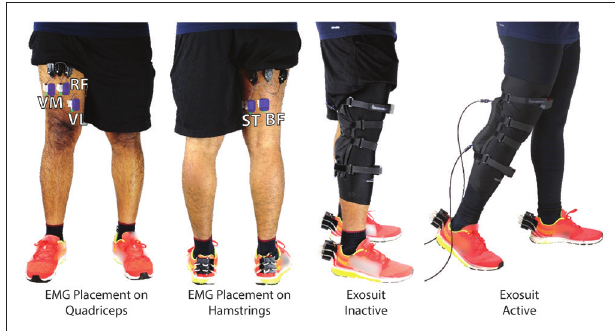
Figure 8 | sEMG sensor placement and exosuit inactive and active phases of the test protocol.